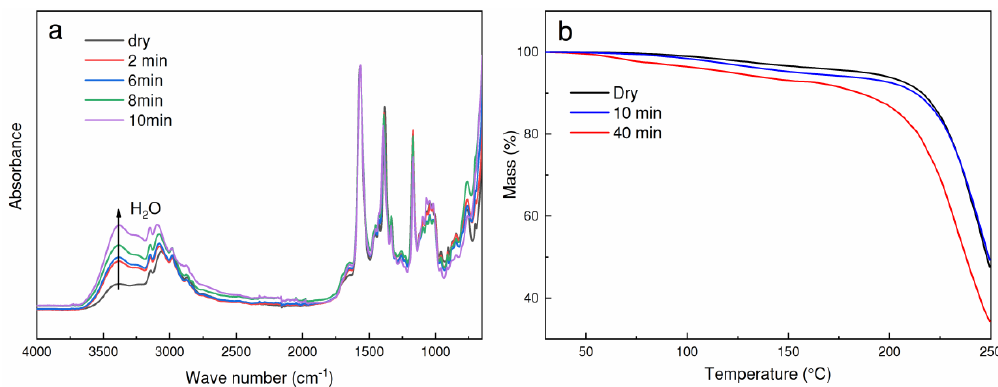
Figure 2. FTIR spectra ( a ) and TGA curves ( b ) of 10 wt % cellulose/EmimAc solution exposed to ambient air.